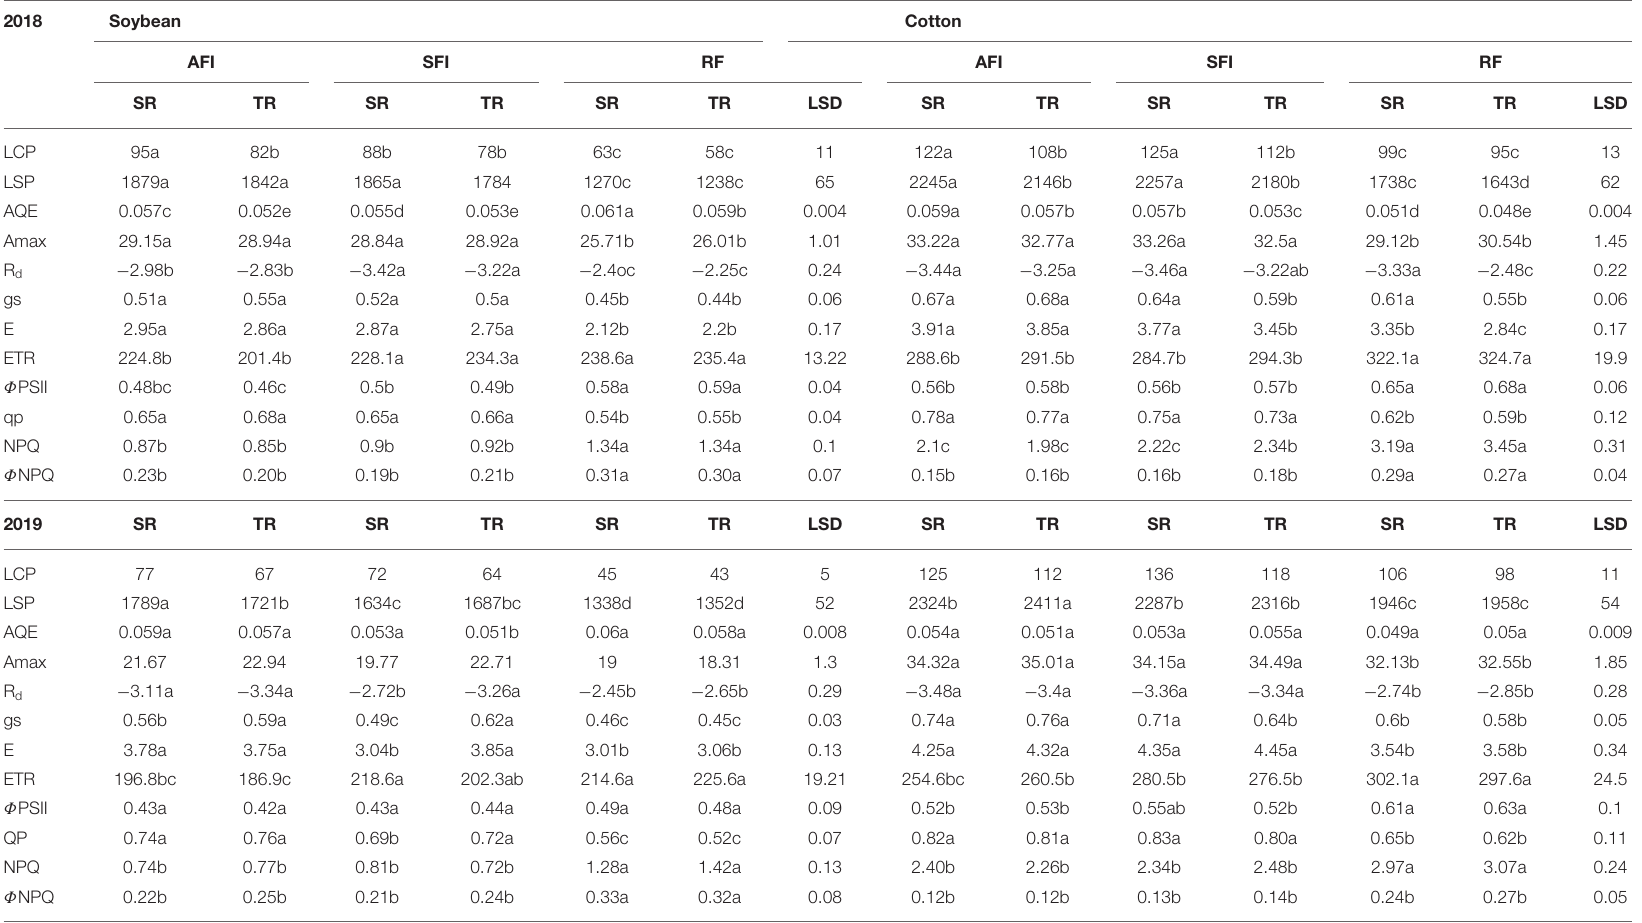
TABLE 2 | Effect of irrigation and planting geometry on soybean and cotton photosynthetic parameters in 2018 and